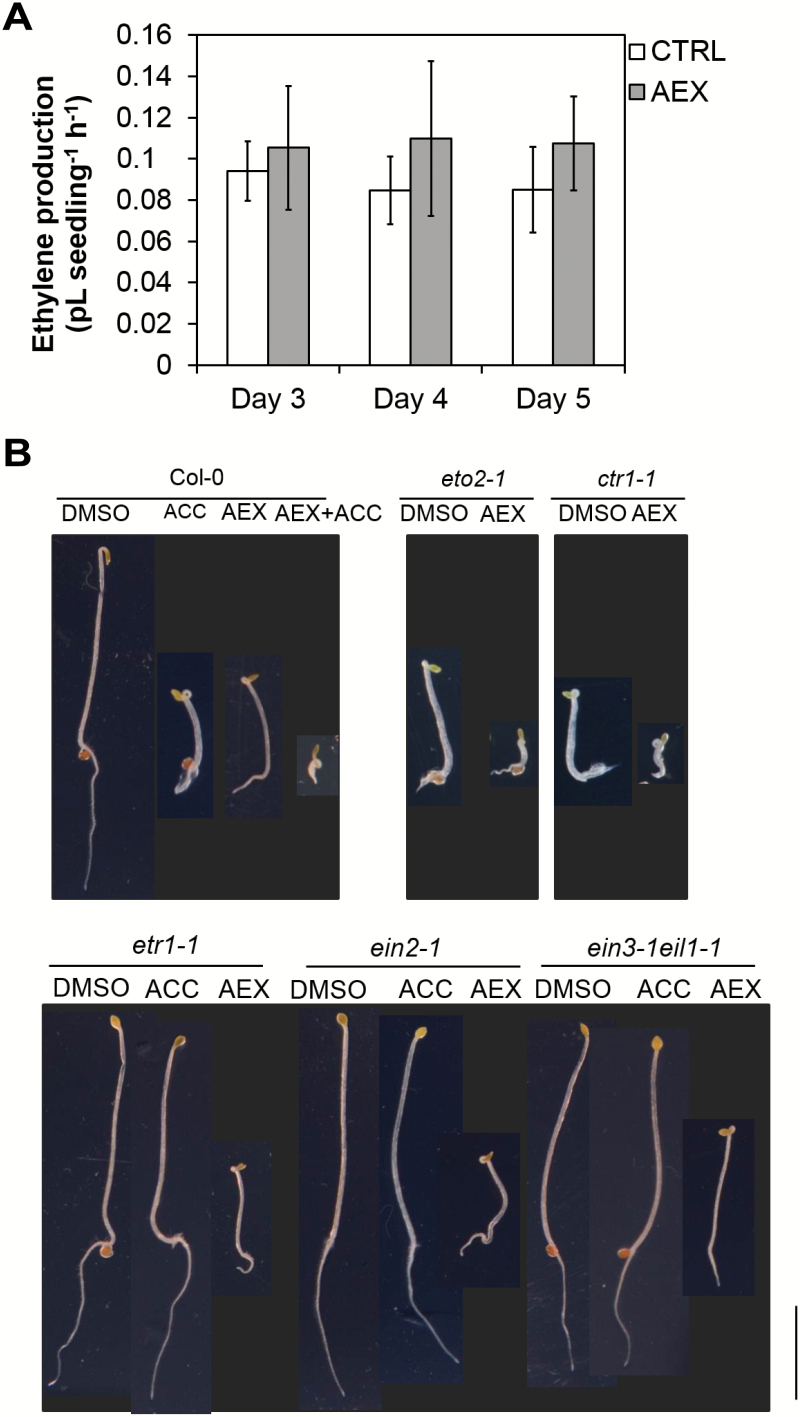
AEX effects on ethylene production and ethylene mutants. (A) Ethylene production of etiolated Col-0 seedlings in the presence of 50 µM AEX was not affected as compared with 0.05% DMSO control. Data are presented as means±SD. The experiments were performed twice with three replicates per condition with highly similar results; results of a representative experiment are shown. Statistical analysis did not detect significant differences between AEX and CTRL. (B) Four-day-old etiolated seedlings of Col-0, eto2-1, etr1-1, ein2-1, and ein3-1eil1-1 grown on medium supplemented with 0.05% DMSO (CTRL), 10 µM ACC, 50 µM AEX, or 10 µM ACC+50 µM AEX (horizontal plates). All treatments contained 0.05% DMSO. The individual photographs were cropped without changing the scale; the black background was post-added. Scale bar: 5 mm. (This figure is available in color at JXB online.)